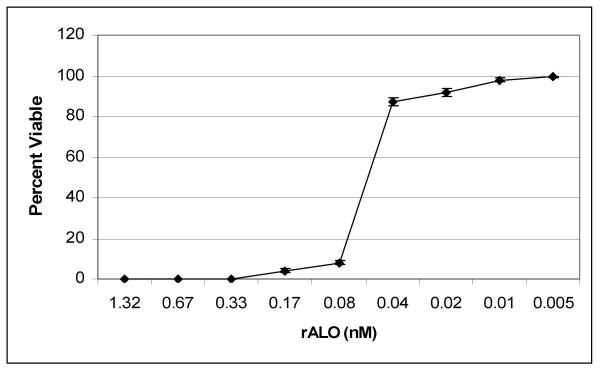
Recombinant ALO lyses primary human neutrophils in a dose dependent manner. Percent viability of PMNs measured by trypan blue after 10 min incubation with various concentrations of rALO in serum free conditions. The means and standard deviations of two independent experiments, each performed in duplicate are shown (Spearman correlation is -0.842, p = 0.004).